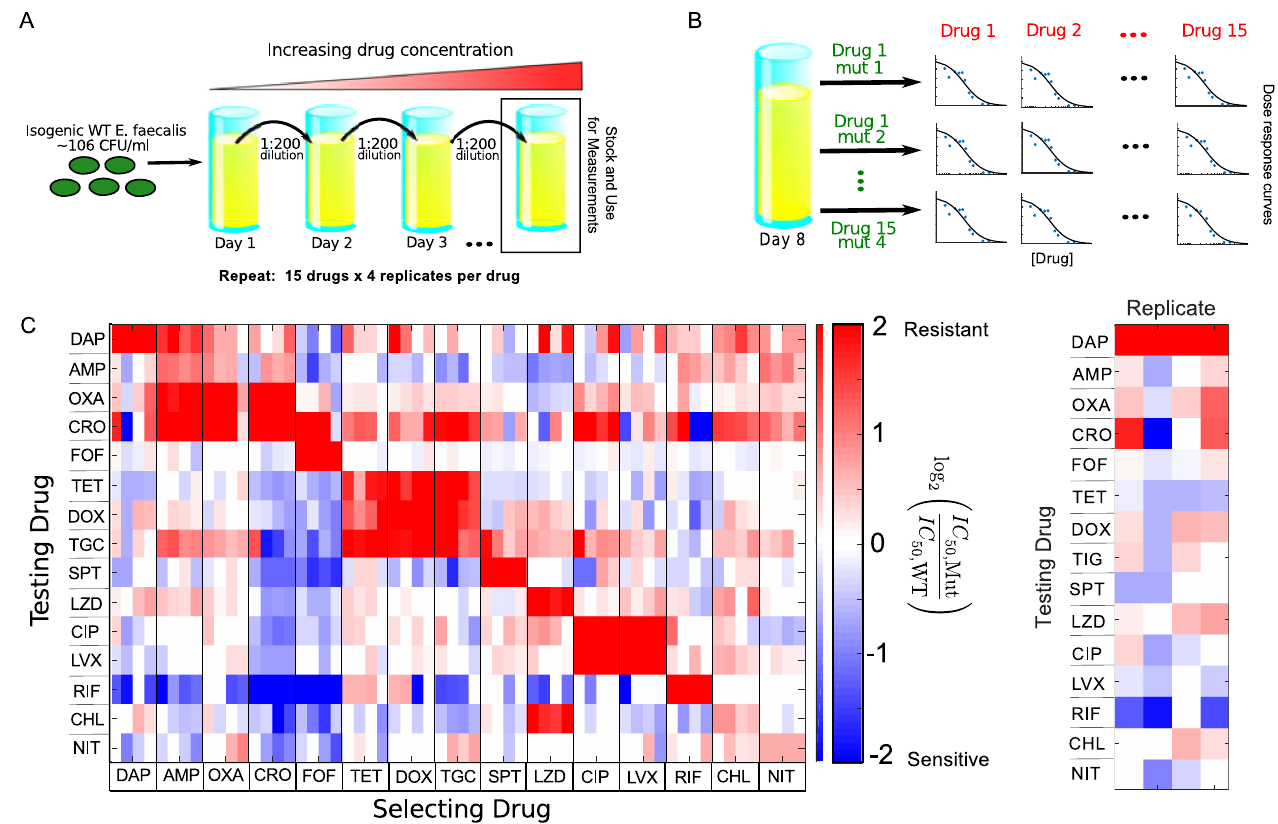
Fig 1. Collateral effects are pervasive and vary across parallel evolution experiments in E . faecalis . (A) E . faecalis strain V583 was exposed to increasing concentrations of a single antibiotic over an 8-day serial-passage experiment with daily 200-fold dilutions (maximum of 60 generations total; see Materials and methods). The evolution was performed in quadruplicate for each drug and repeated for a total of 15 drugs (Table 1). After 8 days, a single mutant was isolated from each population. (B) The IC 50 for each of 15 drugs was estimated for all 60 mutants by nonlinear fitting of a dose-response curve (relative OD) to a Hill-like function (Materials and methods). (C) Main panel: resistance (red) or sensitivity (blue) of each evolved mutant (horizontal axis; 15 drugs × 4 mutants per drug) to each drug (vertical axis) is quantified by the log 2 -transformed relative increase in the IC 50 of the testing drug relative to that of WT (V583) cells. Although the color scale ranges from a 4 × decrease to a 4 × increase in IC 50 , it should be noted that both resistance to the selecting drug (diagonal blocks) and collateral effects can be significantly higher. Each column of the heat map represents a collateral sensitivity profile for one mutant. Right panel: enlarged first column from main panel. Mutants isolated from replicate populations evolved to DAP exhibit diverse sensitivity profiles. Although all mutants are resistant to the selecting drug (DAP), mutants may exhibit either sensitivity or resistance to other drugs. For example, the first and last replicates exhibit cross-resistance to CRO, whereas replicate 2 exhibits collateral sensitivity, and replicate 3 shows little effect. Data underlying this figure can be found in S1 Data. AMP, ampicillin; CHL, chloramphenicol; CIP, ciprofloxacin; CRO, ceftriaxone; DAP, daptomycin; DOX, doxycycline; FOF, fosfomycin; IC 50 , half-maximal inhibitory concentration; LVX, levofloxacin; LZD, linezolid; mut, mutant; NIT, nitrofurantoin; OD, optical density; OXA, oxacillin; RIF, rifampicin; SPT, spectinomycin; TET, tetracycline; TGC, tigecycline; WT, wild-type.